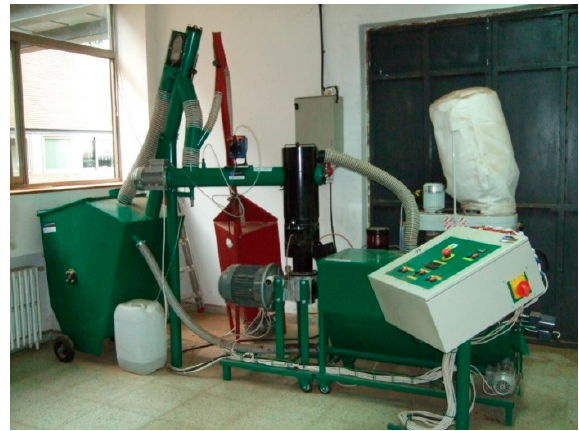
Figure 3. Pelletizing equipment used.